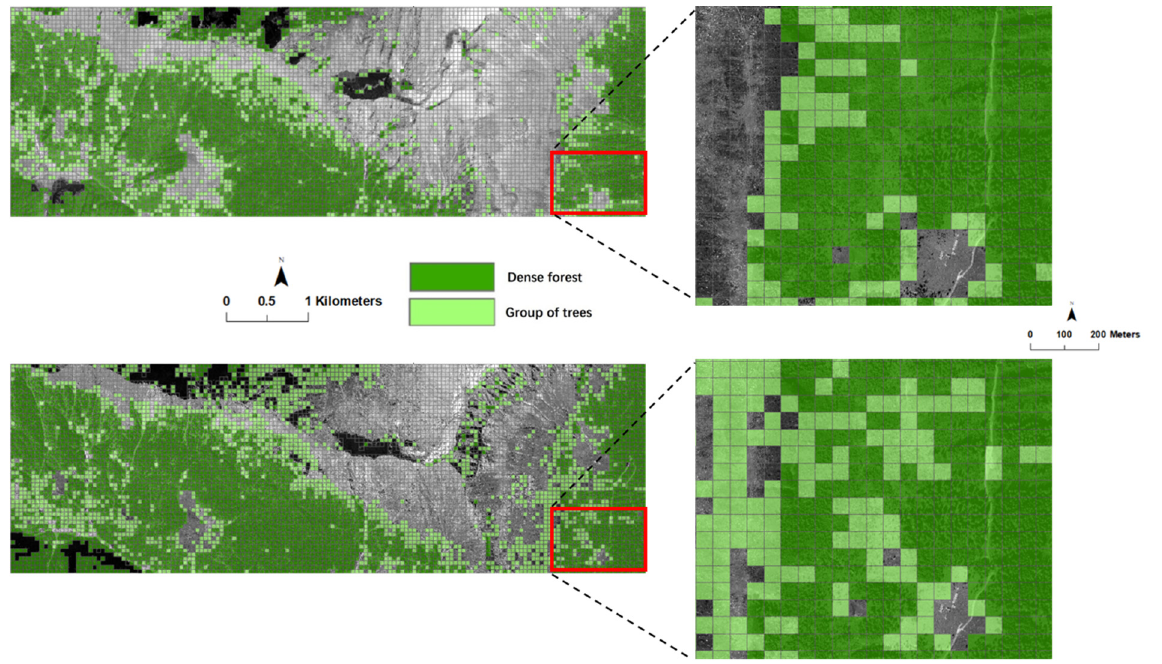
Figure 12. Classification result for study area 2 for time point T1 (images from 1980) ( top ) and time point T2 (images from 2009) ( bottom ). The class “other” belongs to the background areas and is not colored. The colored classification results are overlaid on the B&W aerial images for T1 and T2. Table 3. Overall user’s and producer’s agreement between classifications either with or without hierarchy and visual image interpretation for the three classes “dense forest”, “group of trees”, and “other”. Note that in study area 1 image patches from 2009 were used as training data and were therefore excluded from the agreement